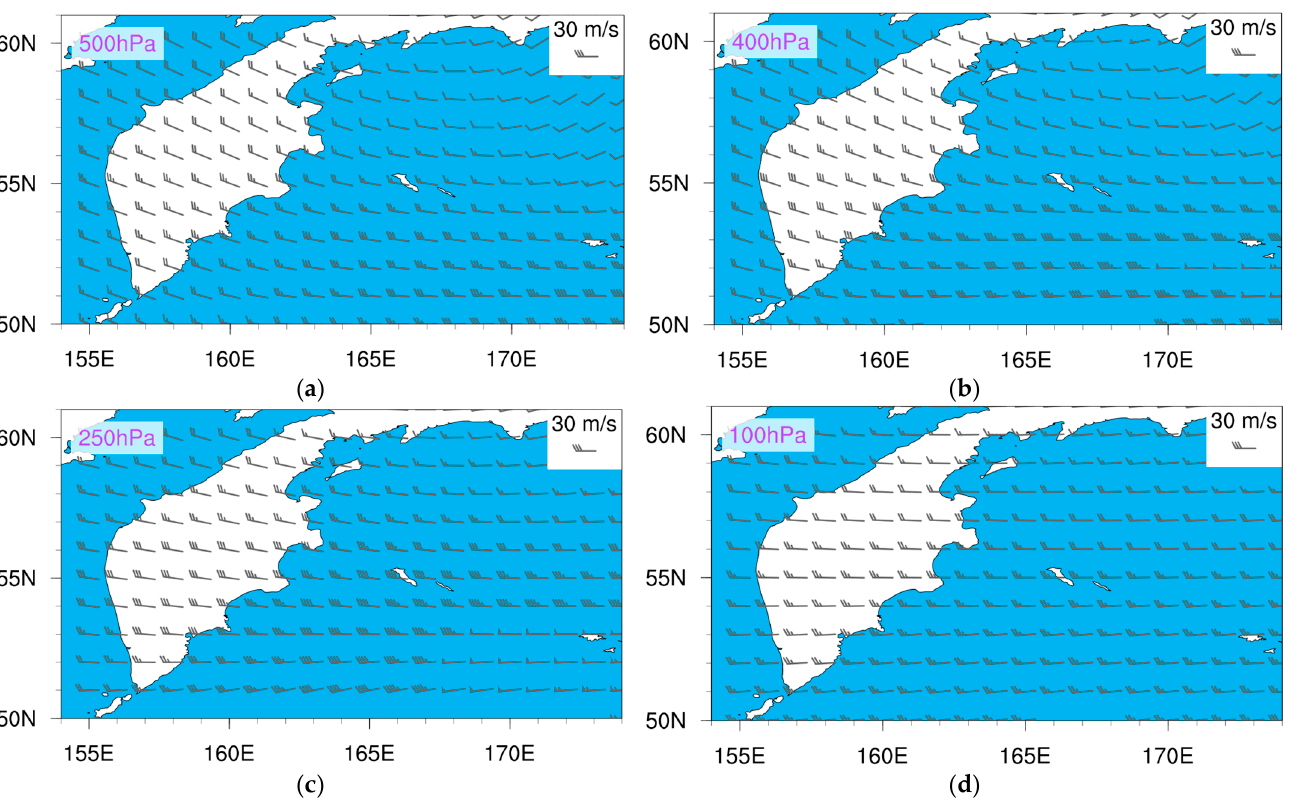
Figure 3. Wind direction and speed at different altitudes at 18:00 UTC, on 11 November 1964: ( a ) 5600 m; ( b ) 7200 m; ( c ) 10,400 m; ( d ) 15,800 m.